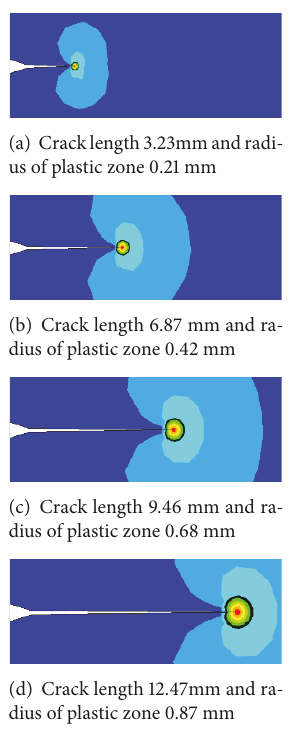
Figure 19: Plastic zone sizes with different